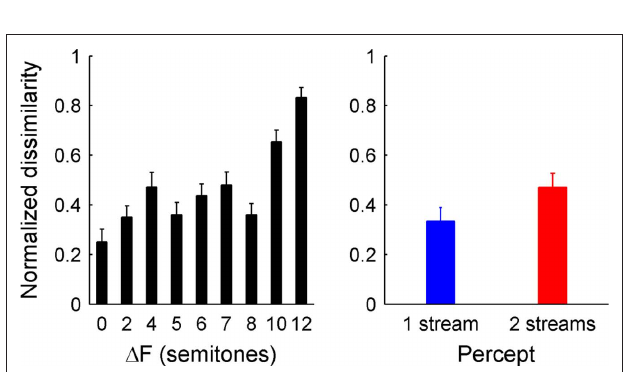
Figure 7 | Dissimilarity index. The left panel shows the dissimilarity index as a function of frequency separation collapsed across percept. The right panel shows the dissimilarity index as a function of percept collapsed across ∆ F conditions in which the percept was bistable. Error bars represent the SE of the mean